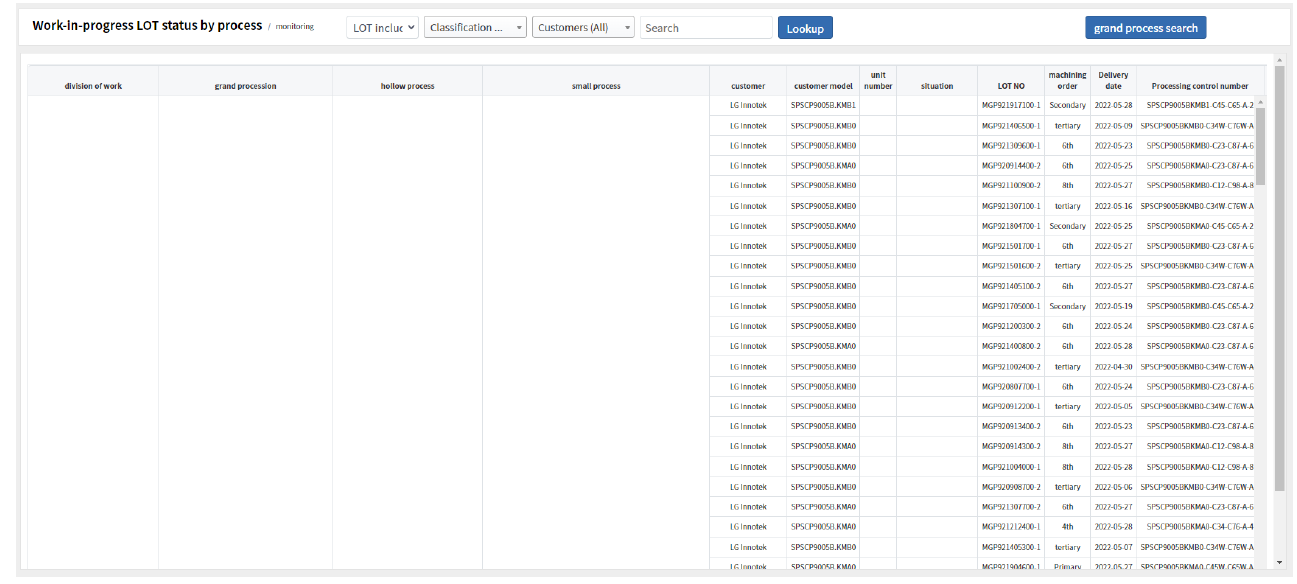
Figure 20. The LOT status for each process.